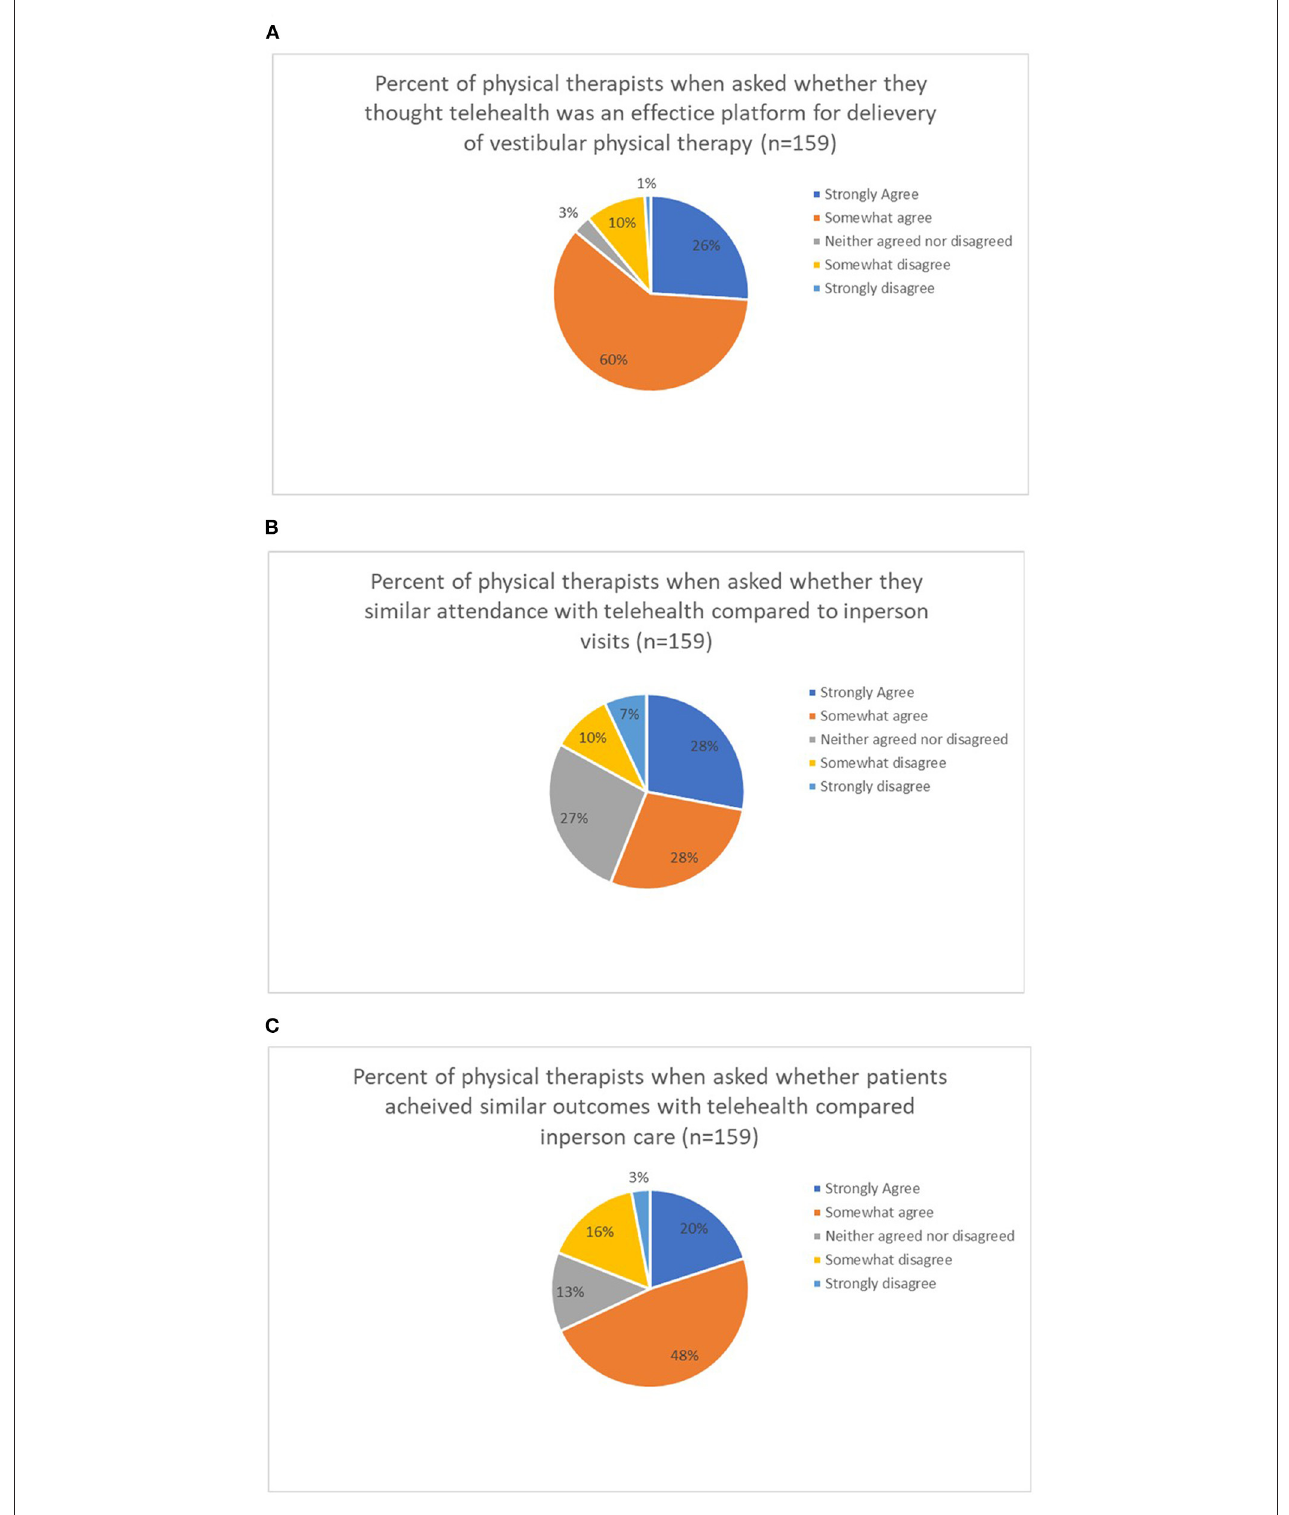
FIGURE 1 | (A–C) Percentage of agreement from physical therapists on general impressions of telehealth physical therapy for vestibular physical therapy services.